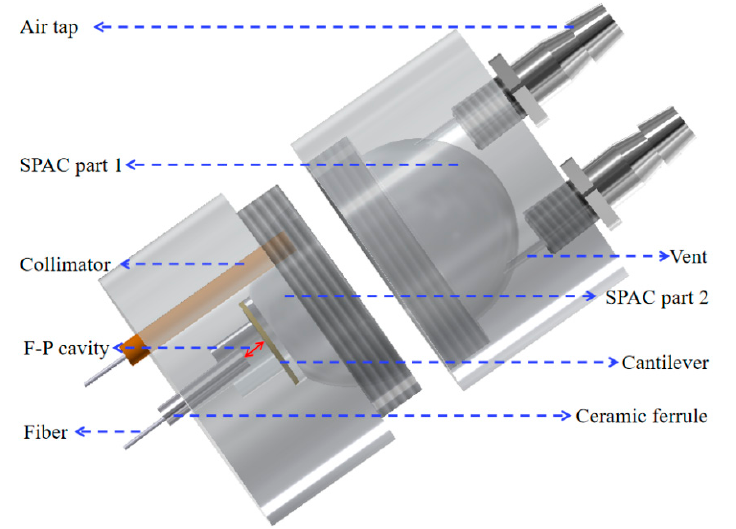
Figure 1. The structure of the SPAC.